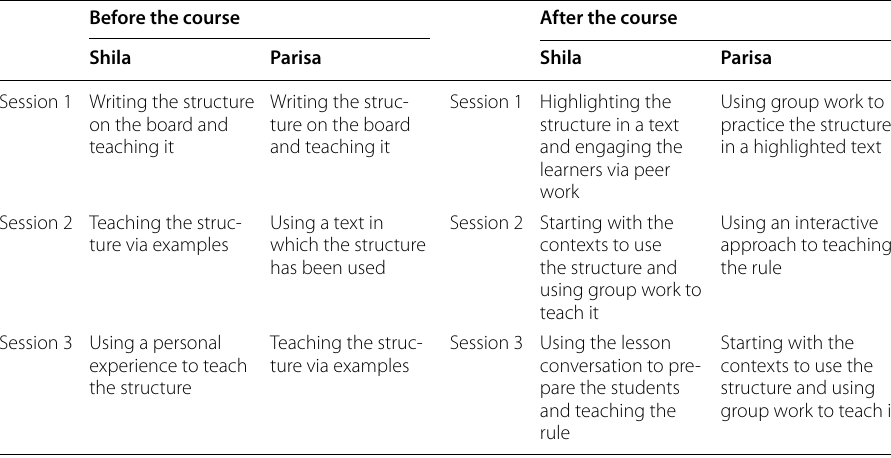
Table 2 The teachers’ grammar